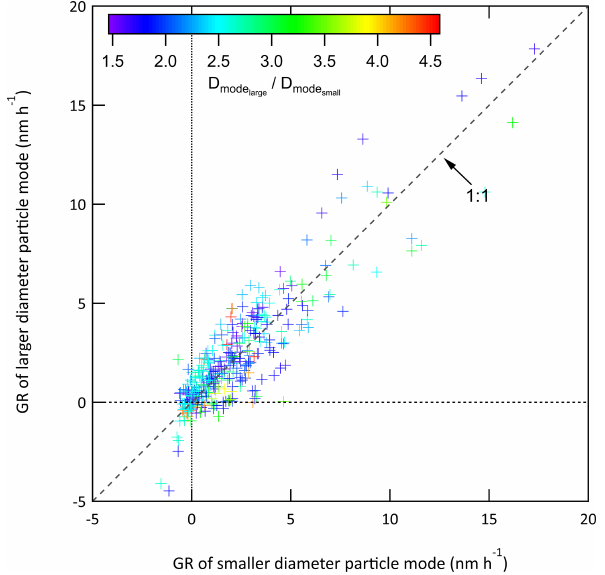
Figure 13. Comparison of all pairs of growth rates calculated for multiple modes tracked at the same time. The GR of the smaller di- ameter mode is plotted on the x -axis and that of the larger diameter mode on the y -axis. The ratio of the diameter of the lognormal fit of the larger particle mode to that of the smaller particle mode is indicated by marker color.